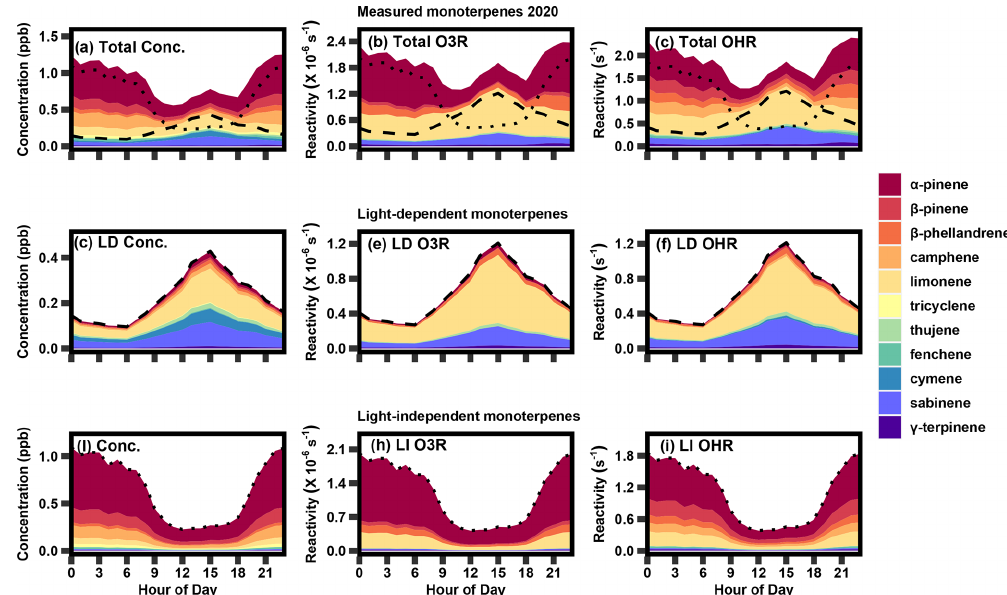
Figure 5. The 2020 summer diurnal profile of (a) measured monoterpene concentration, (b) calculated monoterpene ozone reactivity, and (c) calculated OH reactivity, as well as light-dependent (LD) (d) concentrations, (e) ozone reactivity, and (f) OH reactivity and light- independent (LI) (g) concentration, (h) ozone reactivity, and (i) OH reactivity. The dashed lines in panels (a–c) represent the contribution from LD monoterpenes (d,e,f) , while the dotted lines represent the contribution from LI monoterpenes (g,h,i)